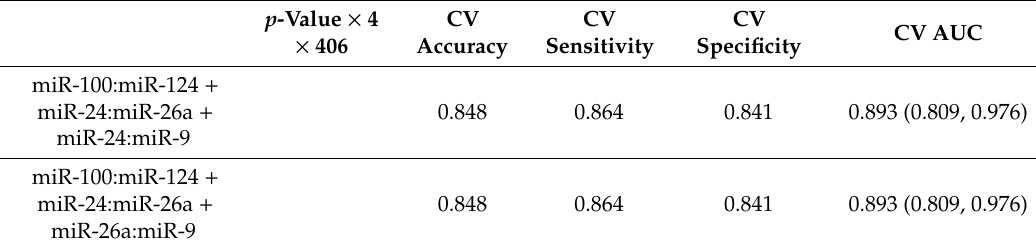
Table 5. Comparison of ALL vs.